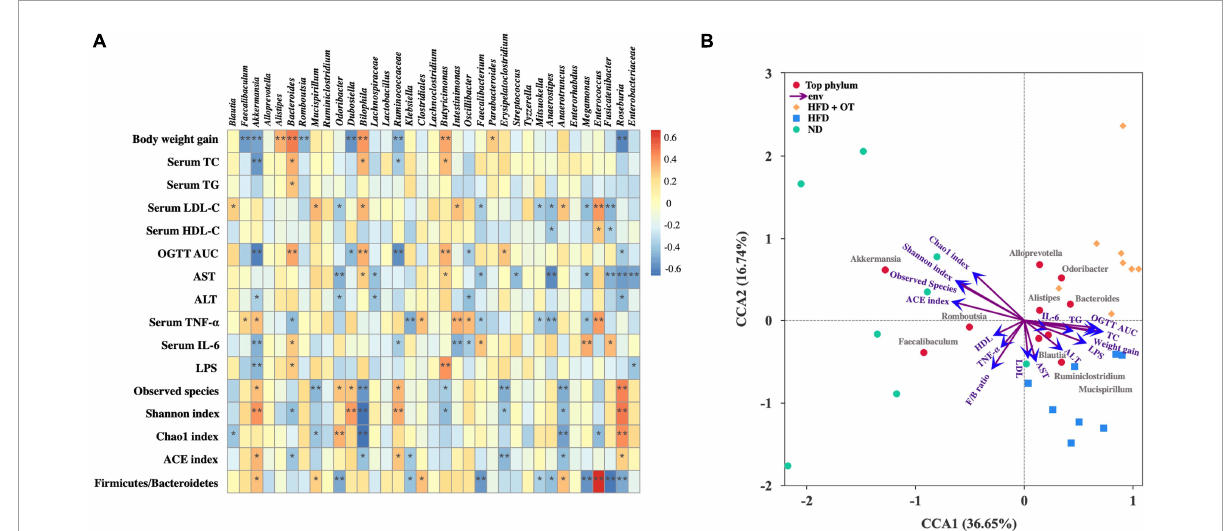
FIGURE7 Correlation between gut microbiota and metabolic parameters. (A) Spearman’s correlation heatmap between gut microbiota and metabolic disorders-related indices. * p < 0.05, ** p < 0.01. (B) CCA/RDA analysis ( n =